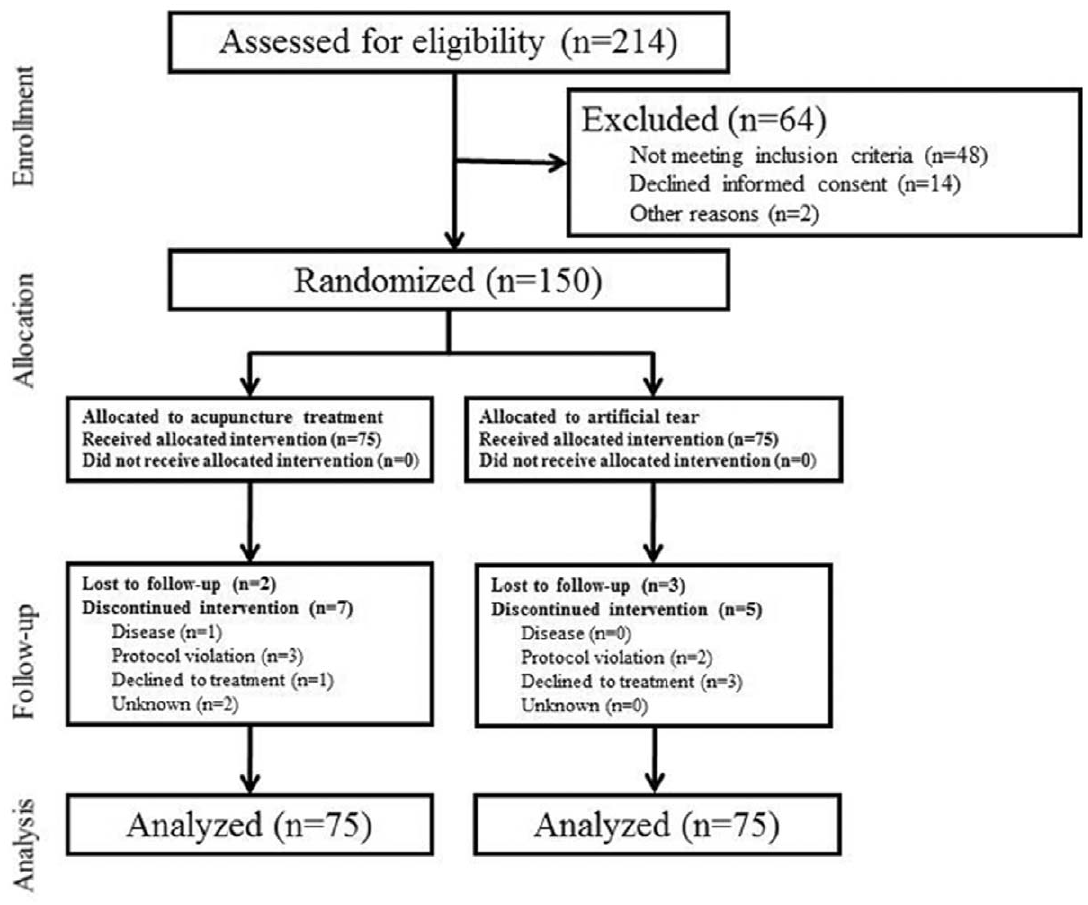
Figure 1. Study flow chart.